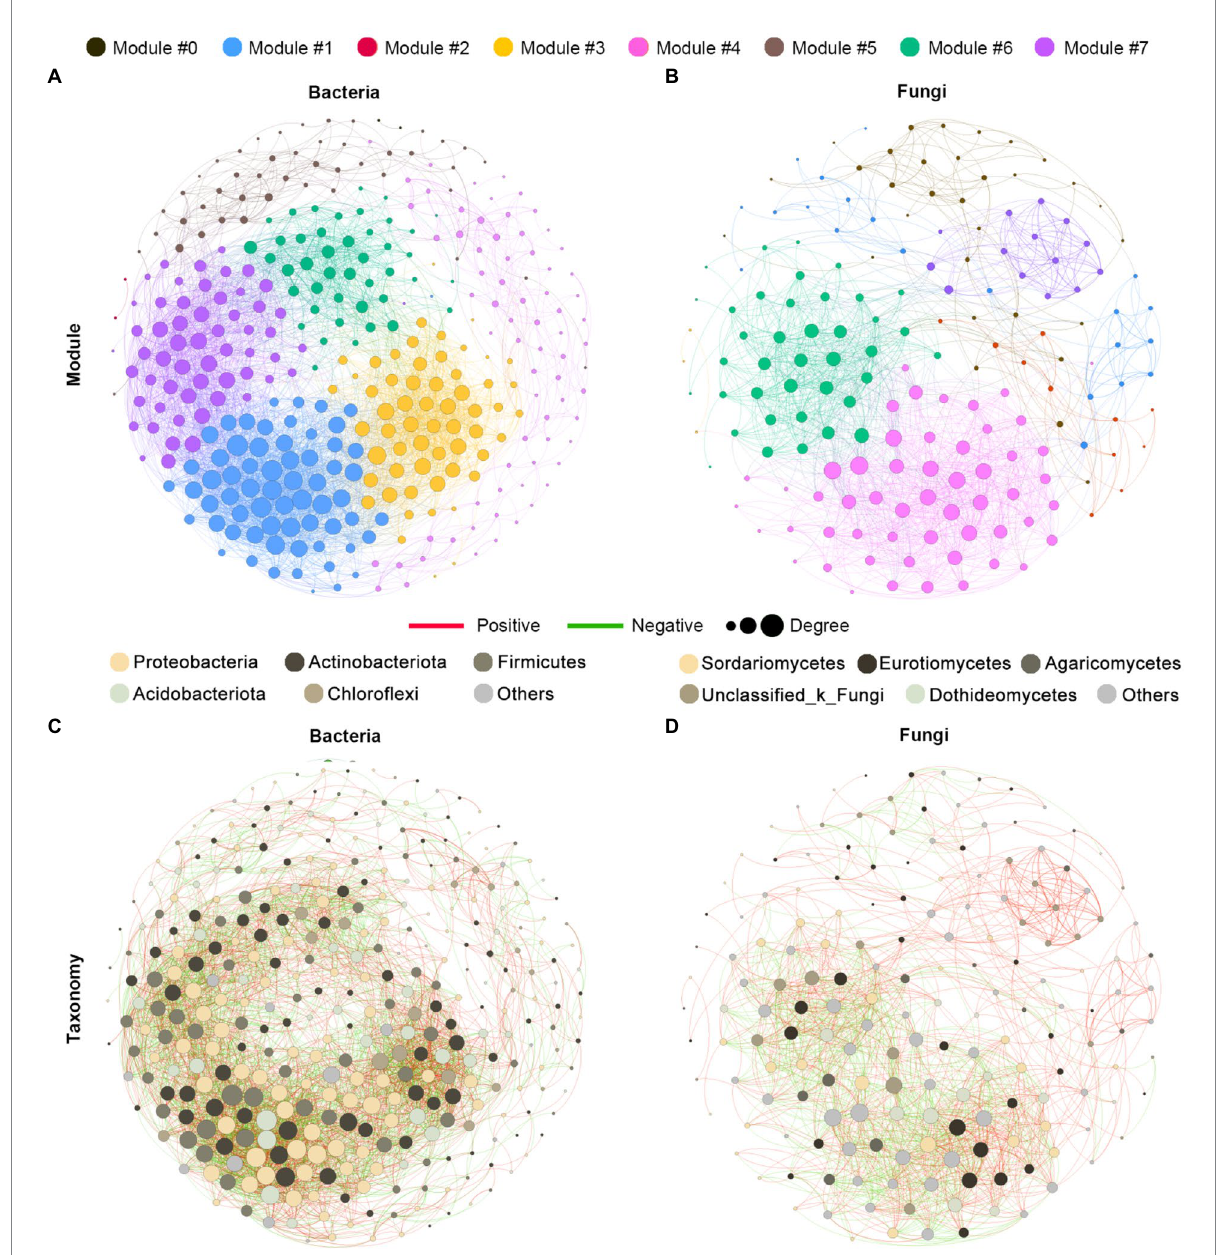
FIGURE 5 Co-occurrence network analysis of the rhizosphere microbial communities of blueberry. The networks are colored based on the modularity class of bacterial (A) and fungal (B) communities and are colored based on the taxonomy taxa of bacteria (C) and fungi (D) . Connections indicated significant ( p < 0.01) correlations, which were divided into positive (Spearman’s p > 0.7; red) or negative (Spearman’s p < − 0.7; green) correlations. The size of each node is proportional to the degree of the